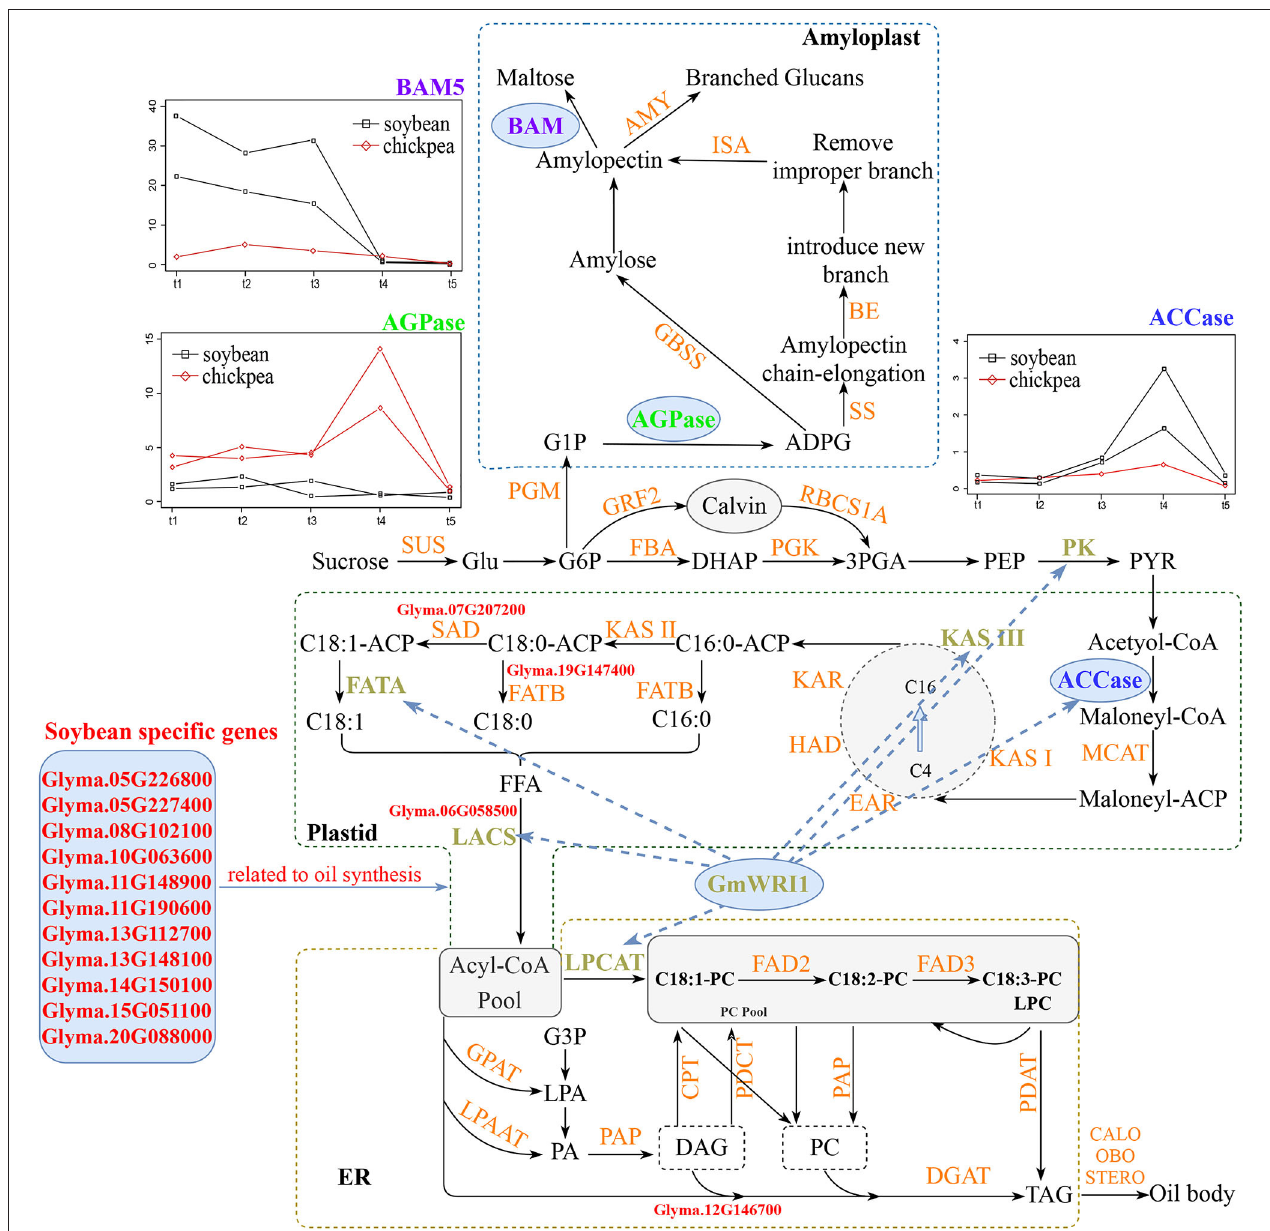
FIGURE 6 | Molecular mechanisms for the difference in seed oil and starch content between soybean and chickpea. In soybean, soybean-specific fatty acid synthesis genes (red), common highly expressed ACCase (blue), and common oil synthesis-related genes ACCase , KAS , KAR , ACP , and LACS co-expressed with WRI1 (brown) are responsible for high seed oil content, while common starch degrading enzyme BAM5 (purple) highly expressed at soybean early seed development stage is responsive for low seed starch content. In chickpea, common AGPase (green) highly expressed at chickpea middle seed development stage is responsible for high seed starch content, while no oil synthesis genes co-expressed with common WRI1 is responsible for low seed oil content. LACS, long-chain acyl-CoA synthetase; AGPase, ADP-glucose pyrophosphorylase; BAM-5, beta-amylase-5; ACCase, acetyl CoA